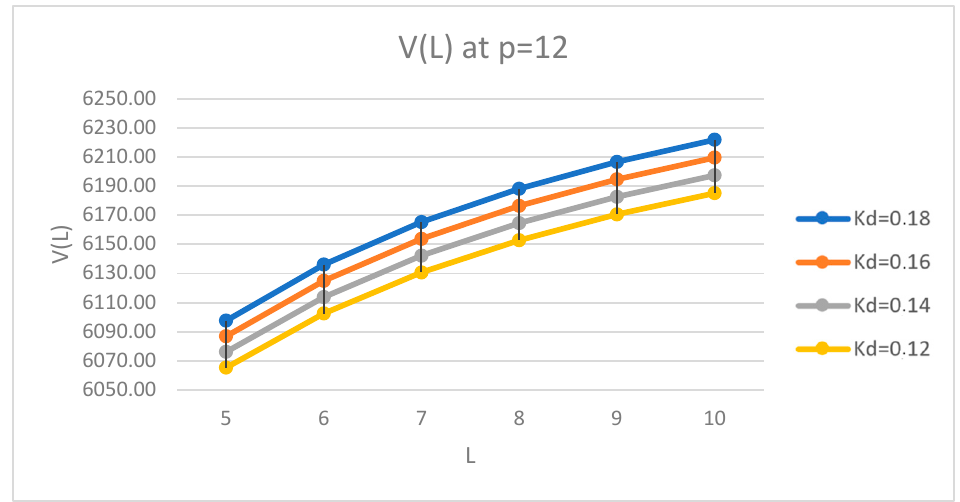
Figure 15. Dependence of the company capitalization, V , on leverage level L at different debt cost k d